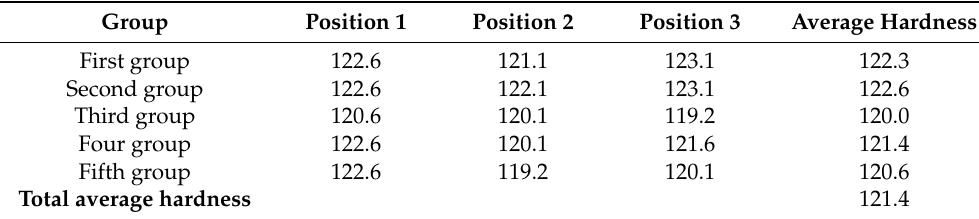
Table 7. Micro-hardness of base metal (HV1).